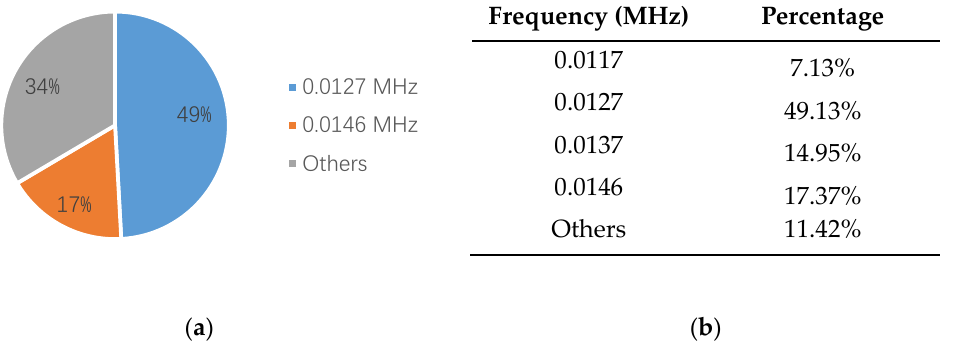
Figure 13. The frequency proportion between 0.01–0.02 MHz in the first specimen: ( a ) pie chart; ( b ) table.